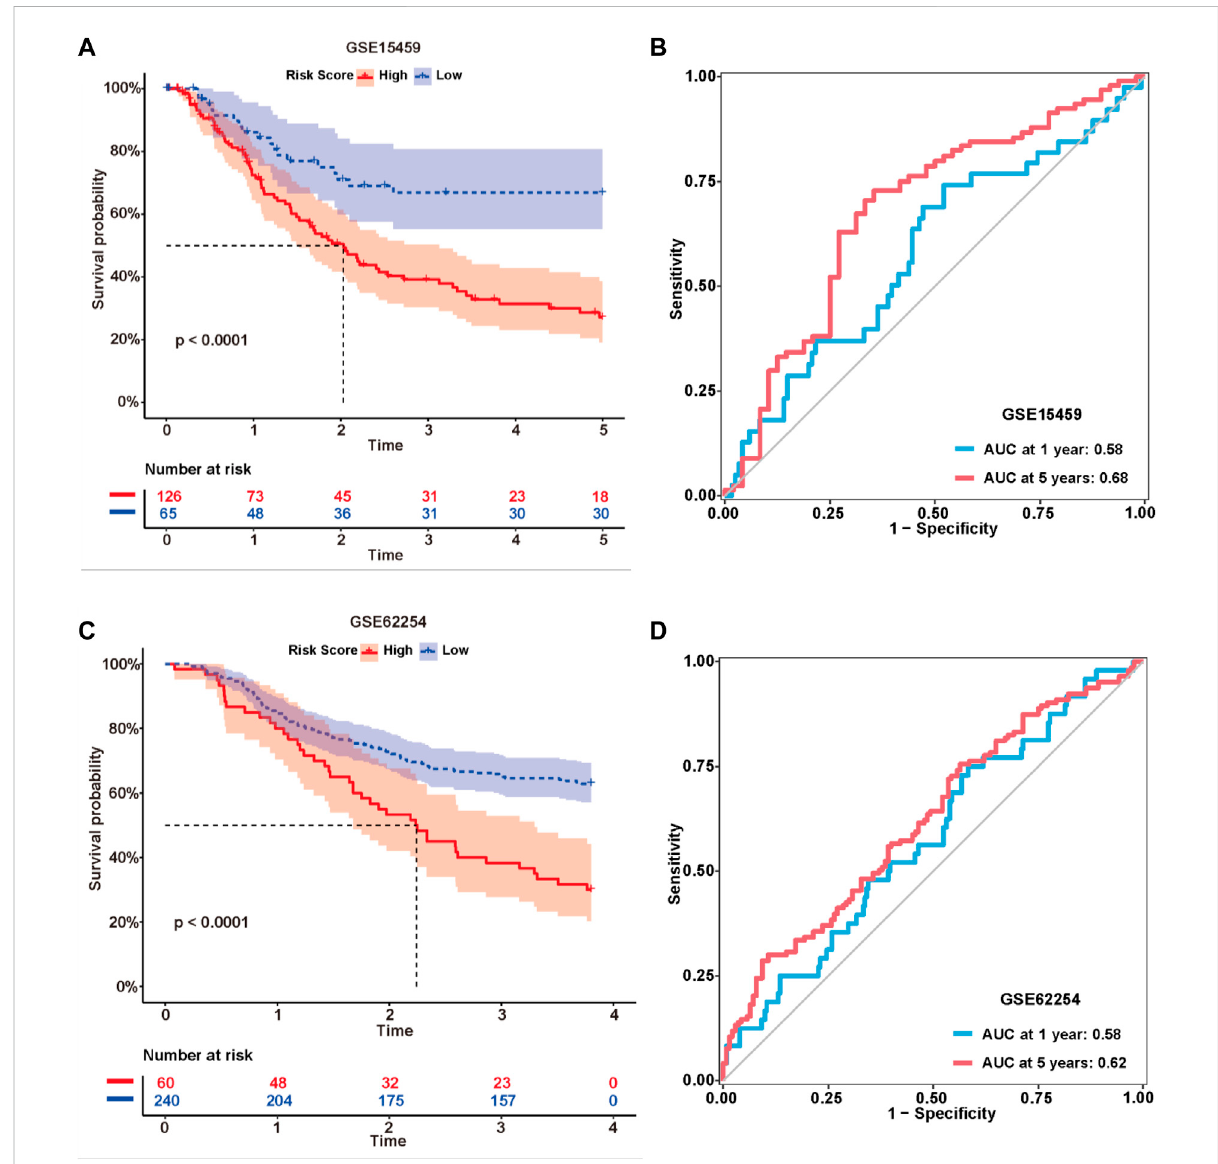
FIGURE 9 External validation of the risk model. Kaplan-Meier curves of the lncRNA signature for predicting the OS of patients in the GSE15459 (A) and GSE62254 (C) datasets. Time-dependent ROC curves of the signature in the GSE15459 (B) and GSE62254 (D) datasets.